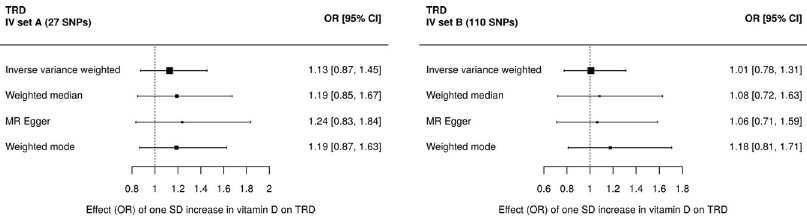
Fig. 1 Two-sample Mendelian randomization (MR) of vitamin D treatment-resistant depression (TRD). MR using ( a ) the 27 IVs from IV set A, from the GWAS of vitamin D in the UK Biobank split sample, or ( b ) the 110 IVs from IV set B, from the previous GWAS of vitamin